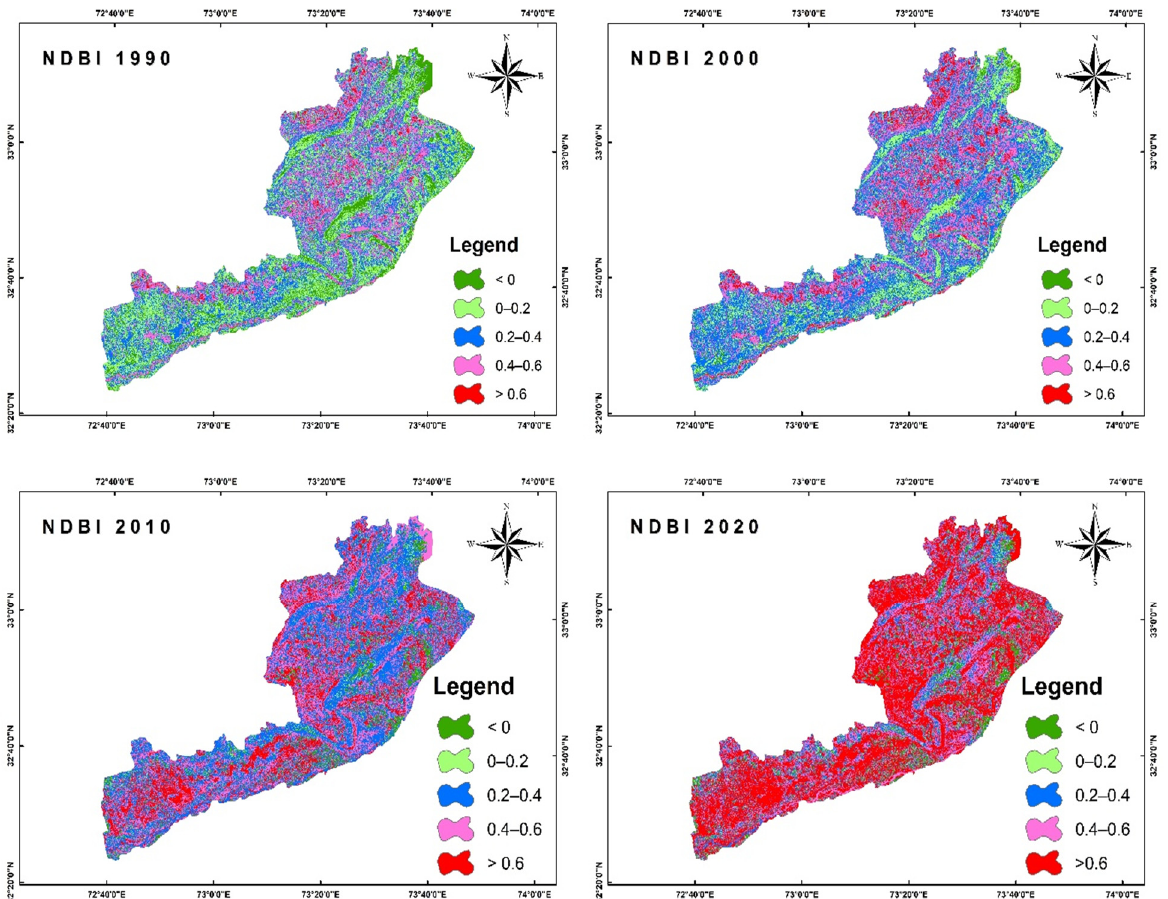
Figure 8. Normalized difference built-up index maps of the research area.